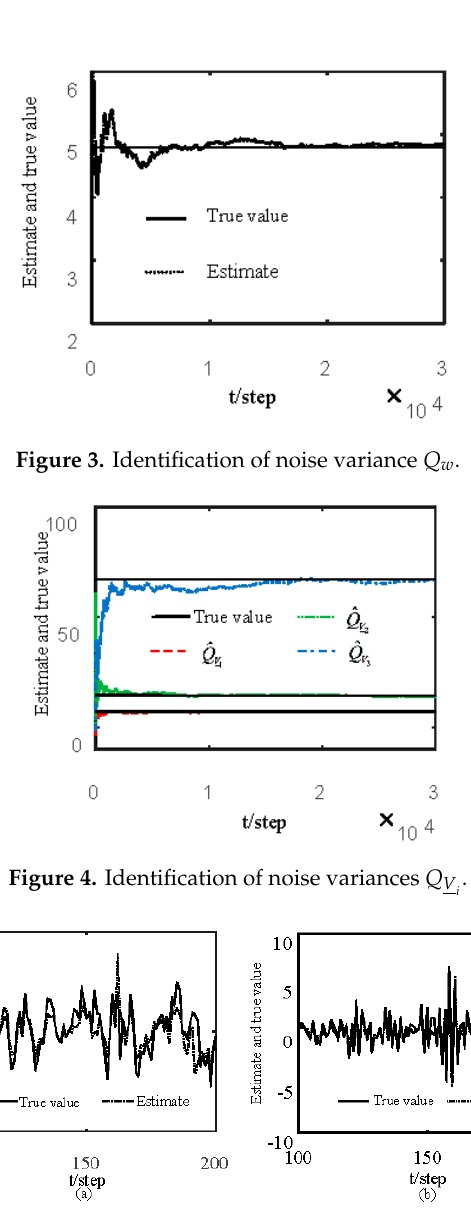
Figure 2. Local estimates of unknown parameter